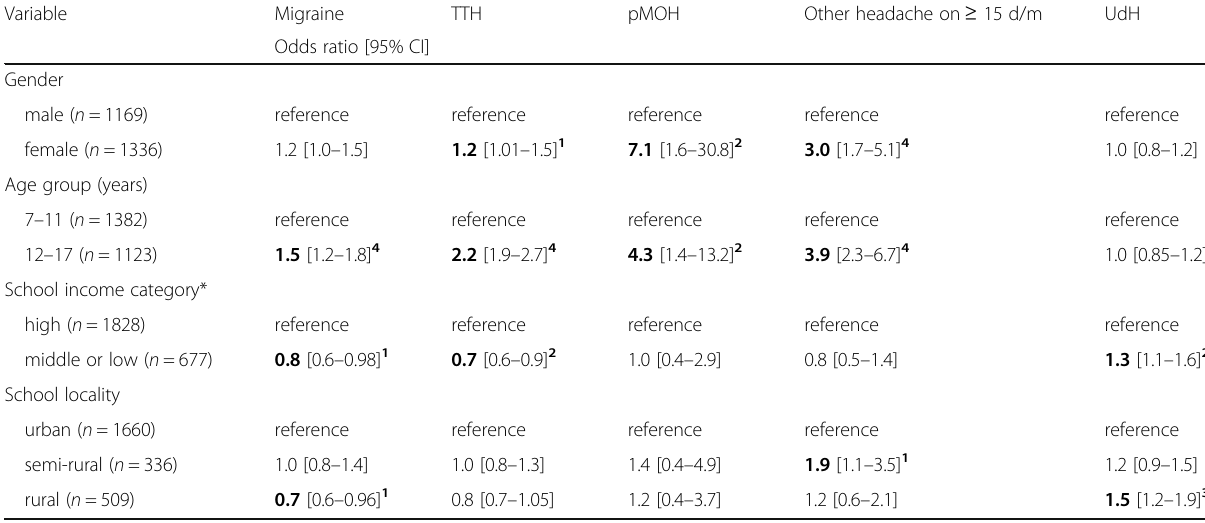
Table 3 Bivariate logistic regression analyses of headache type versus demographic variables ( N = 2505) Variable